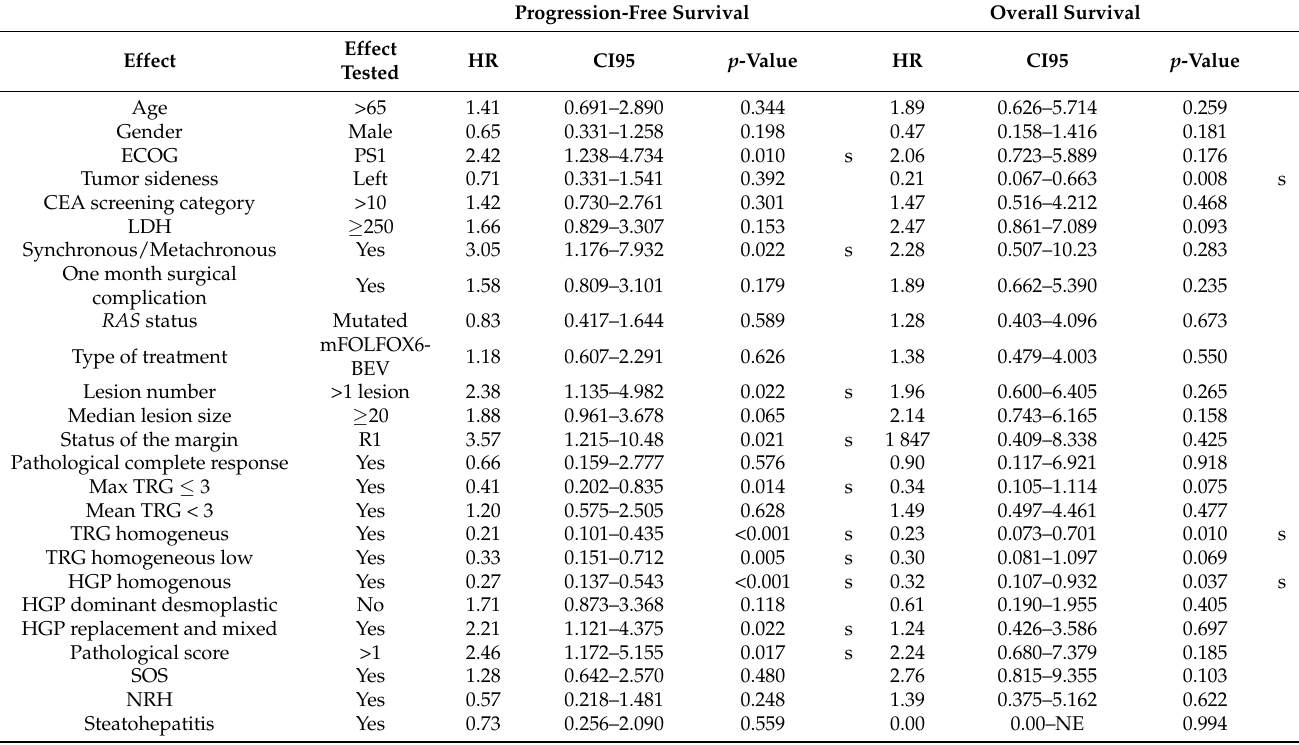
Table 4. Univariate analysis for progression-free survival and overall survival. Progression-Free Survival Overall